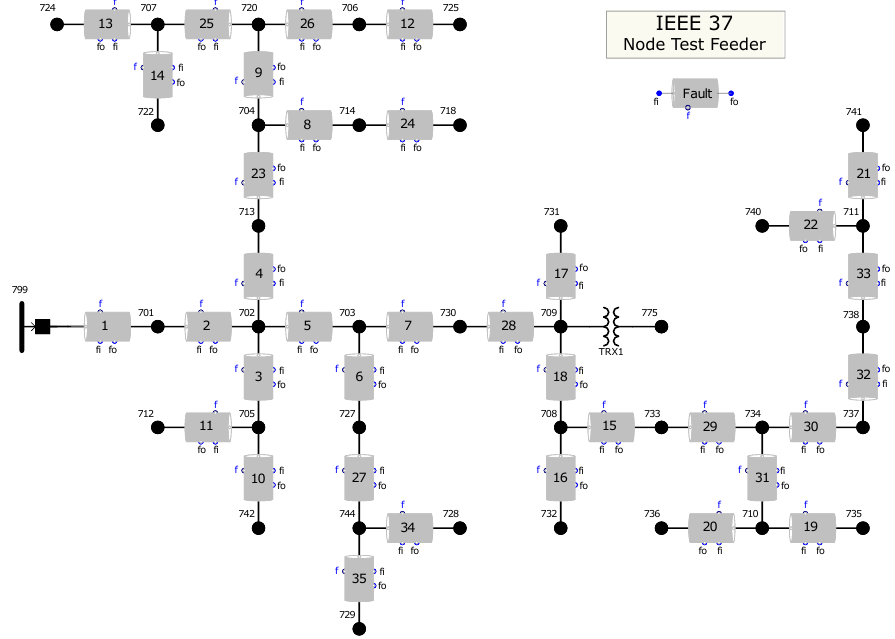
Figure 10. Testbed network for comparative (IEEE 37 Node Test Feeder).